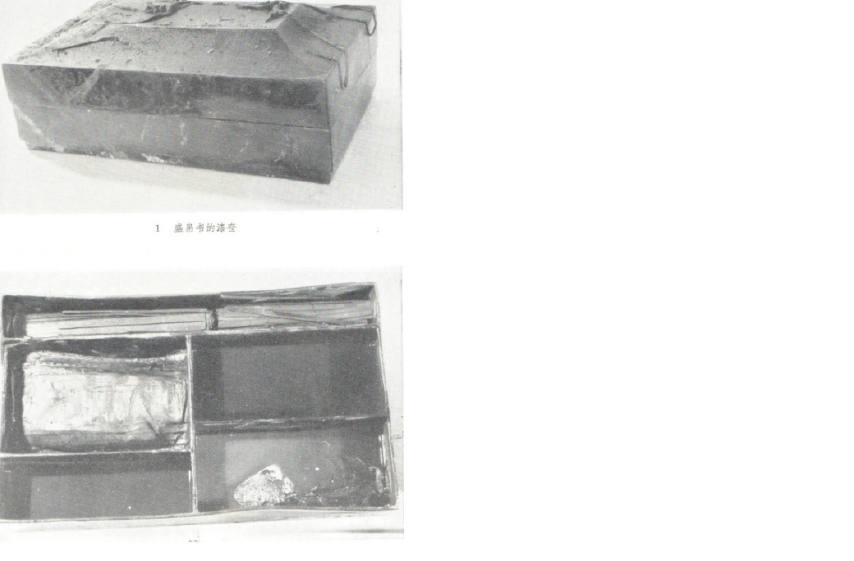
Figure 4. Lacquer casket found in Tomb 3 of Mawangdui from the Han dynasty (The English in the figure should be: The lacquer casket of silk manuscripts).